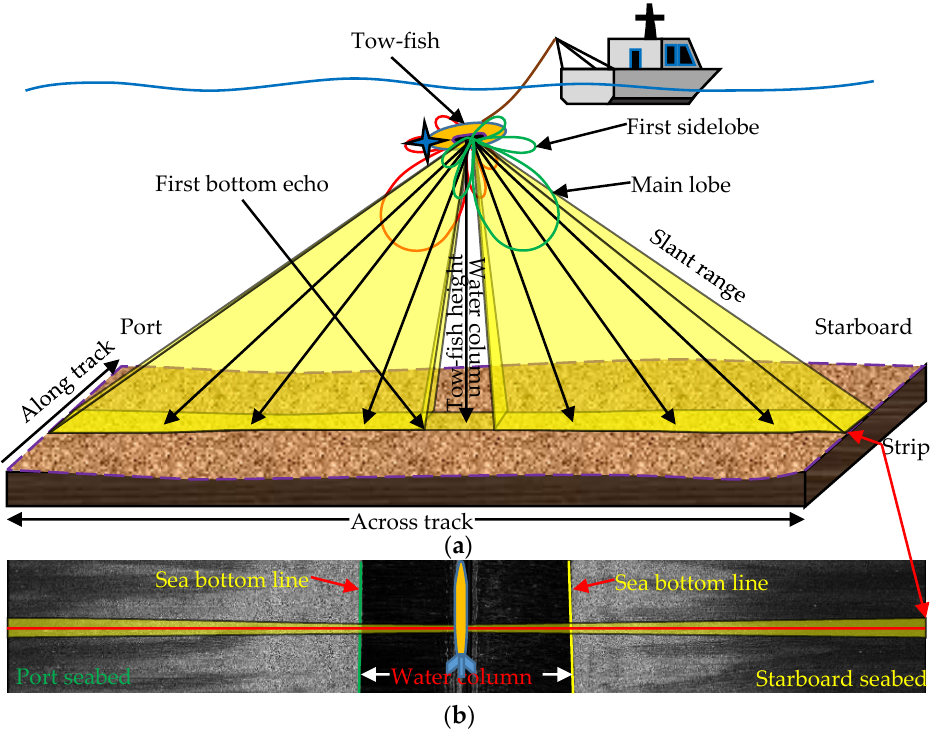
Figure 1. Working principle of SSS. ( a ) shows the imaging principle of SSS. ( b ) shows a typical SSS waterfall image.